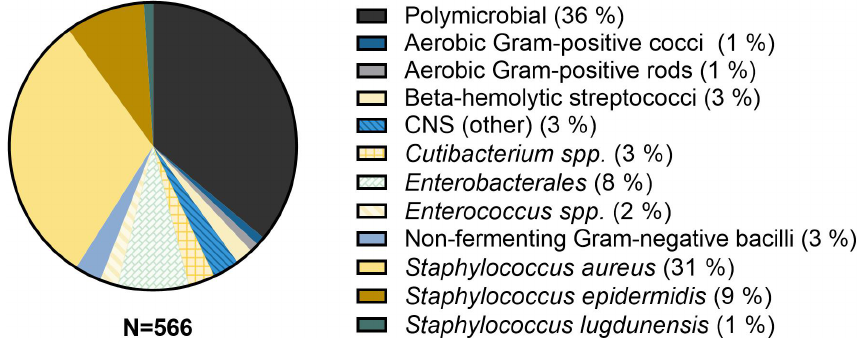
Figure 2. Microbiological epidemiology. CNS – coagulase-negative Staphylococci, spp. – species (not further specified).